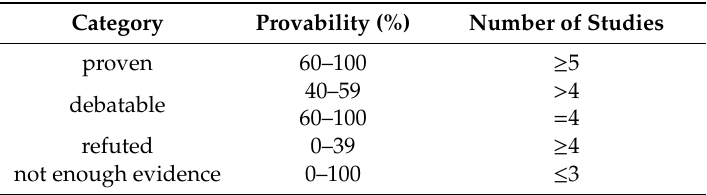
Table 1. Designating the provability of the